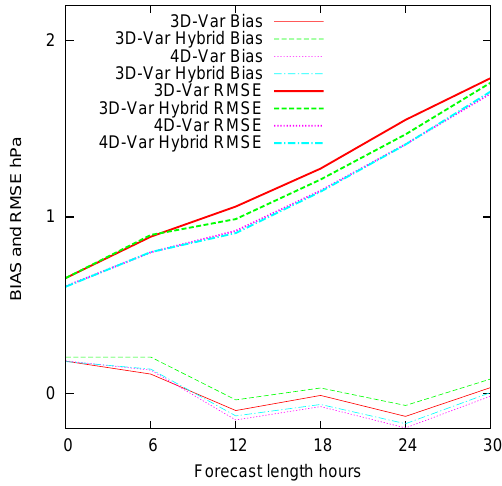
Fig. 11. Bias and standard deviation verification scores for mean sea level pressure forecasts over a Scandinavian domain averaged over the period 19 January–29 February 2008 and given as func- tions of forecast length. The control forecasts from the 3D-Var (red curve), the 3D-Var hybrid (green curve), the 4D-Var (blue curve) and the 4D-Var hybrid (pink curve) experiments are included. Fore- casts have been run with 6th hourly lateral boundary conditions.